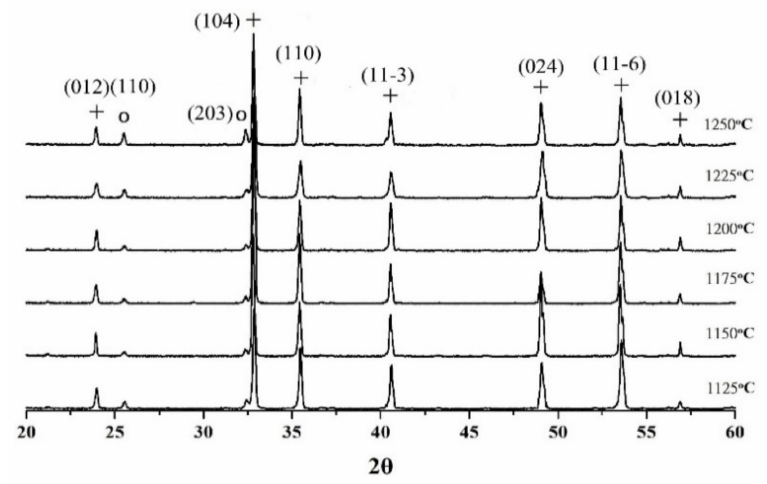
Figure 2. XRD analysis of (Mg 0.6 Zn 0.4 ) 0.95 Ni 0.05 TiO 3 sintered at 1125–1250 ◦ C for 4 h. [+: (Mg 0.6 Zn 0.4 ) 0.95 Ni 0.05 TiO 3 , O: (Mg 0.6 Zn 0.4 ) 0.95 Ni 0.05 Ti 2 O 5 ]. Table 1. The calculated lattice parameter of (Mg 0.6 Zn 0.4 ) 1 − y Ni y TiO 3 ceramic with y =